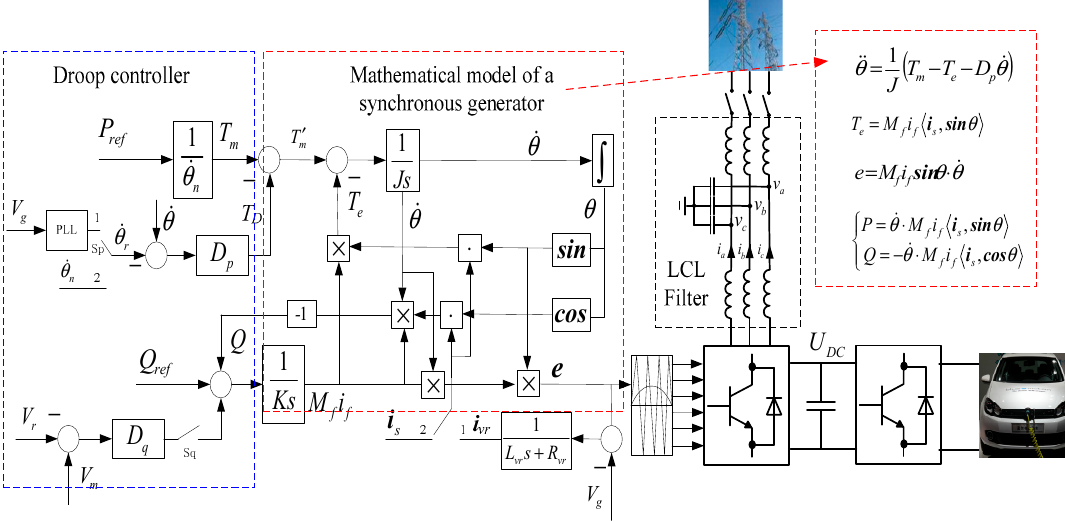
Figure 3. The topology of EV bidirectional charging circuit and its’ virtual synchronous machine (VSM) controller.